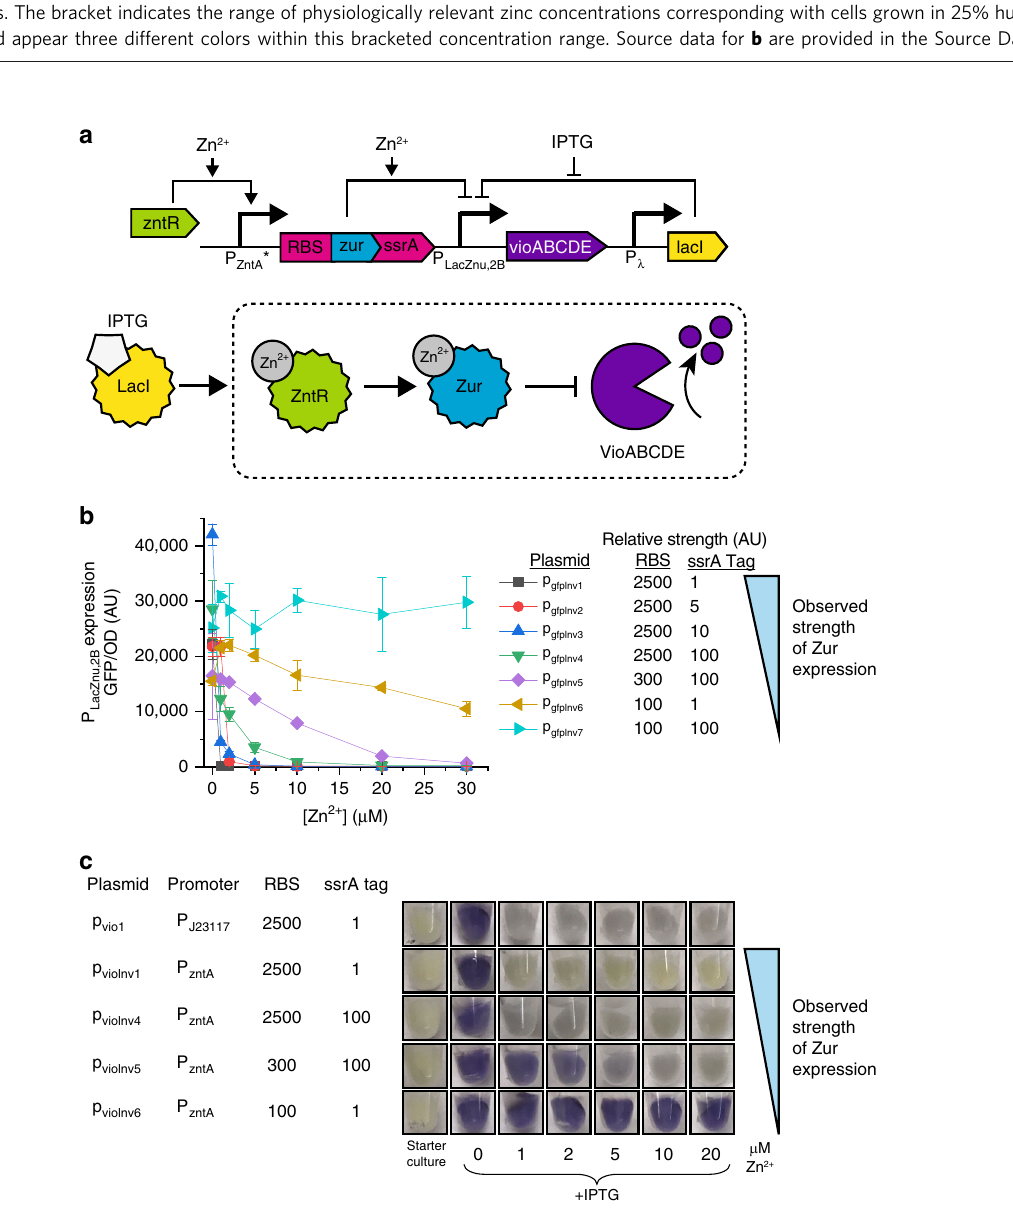
Fig. 3 Tuning color thresholds with an inverter. a Circuit diagram and schematic depicting inverter method to modulate P LacZnu,2B expression. During the pre-assay culture stage, LacI represses all pigment production. Upon IPTG addition, the activator ZntR controls expression of Zur: increasing concentrations of zinc correspond with increased amounts of Zur, which leads to decreasing expression from P LacZnu,2B , serving as an effective inverter of the expected output. The RBS and ssrA tag modulate the amount of Zur produced and thus the amount of zinc needed to activate full Zur repression. b Fluorescent characterization of Zur inverter circuits. A library of circuits was assembled with different relative levels of Zur. RBS values are the predicted relative RBS strength, and ssrA values indicate the relative strength of degradation (ssrA strength = 1 corresponds with no added degradation tag, and ssrA strength = 100 corresponds with the strongest degradation tag). Decreasing Zur expression levels correspond with cells that shut off expression at higher zinc concentrations. c Visual assessment of cells with tunable violacein expression. Overnight starter cultures were added to fresh media that contained IPTG and speci fi ed zinc concentrations and grown for four hours. Violacein quanti fi cation is shown in Supplementary Fig. 8. Source data for b are provided in the Source Data fi